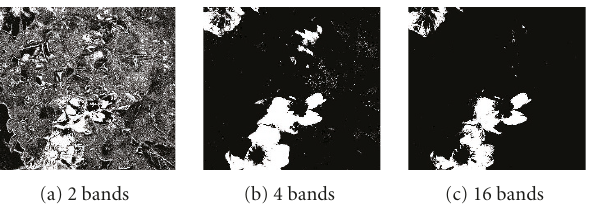
Figure 6: The results of detected image as a function of the number of bands used out of 31 input